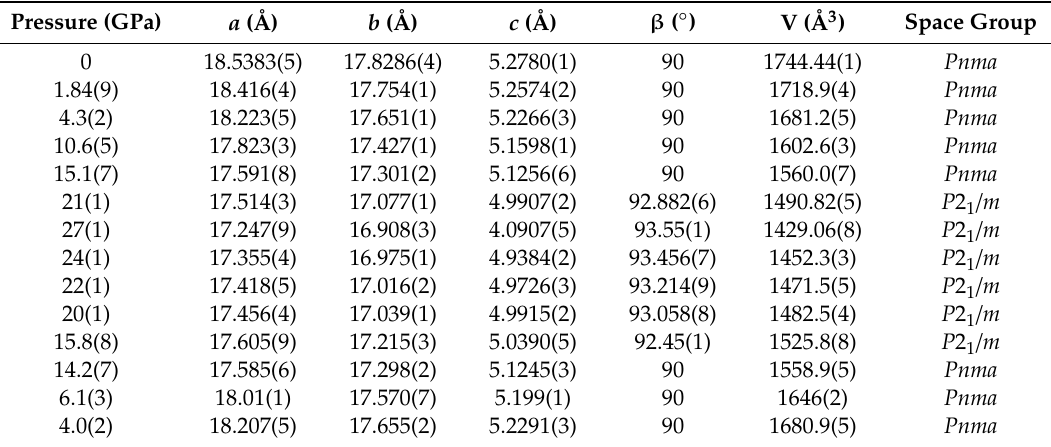
Table 3. Unit cell parameters of gedrite at various pressures and 298 K.